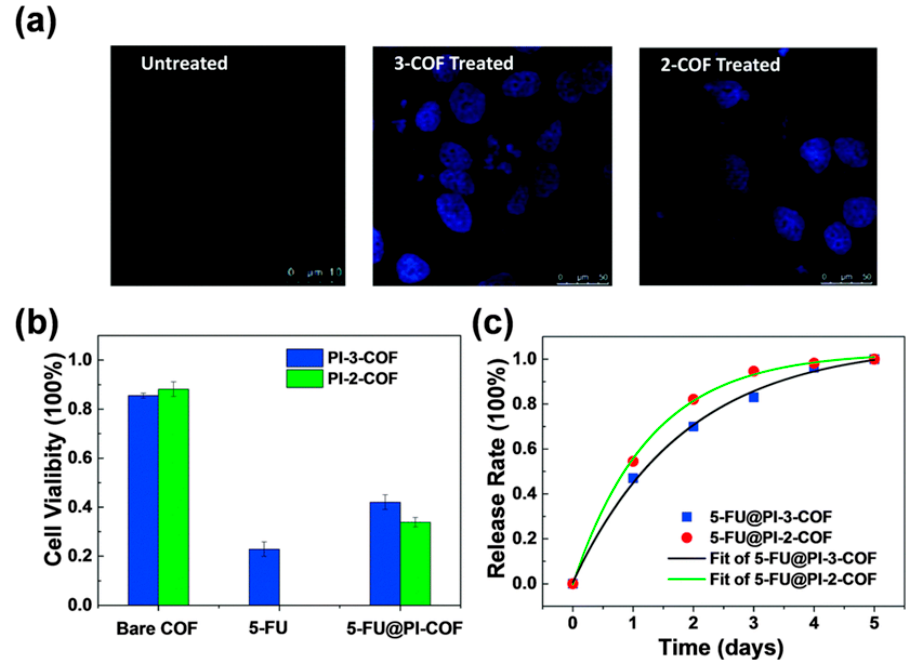
Figure 10. ( a ) Confocal images for cell uptake; ( b ) Quantitative MTT analysis for cell viability; ( c ) Release profiles of drug loaded COFs. Reproduced with permission from [323]. Copyright Royal Society of Chemistry,